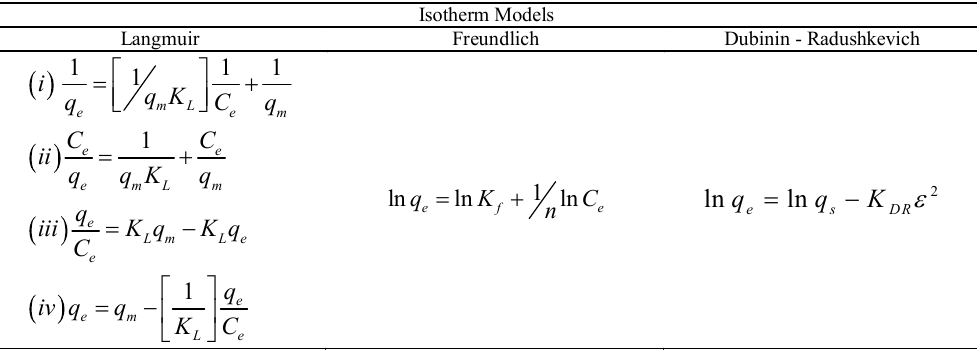
Table 3: Linearized isotherm models Isotherm Models Langmuir